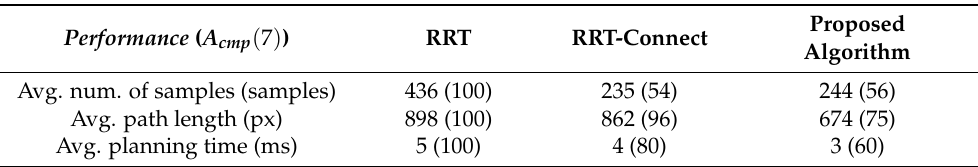
Table 8. Experimental result of Map 7 (the parentheses to the right of each value are relative ratios based on RRT 100% ( x cmp ( 7 )